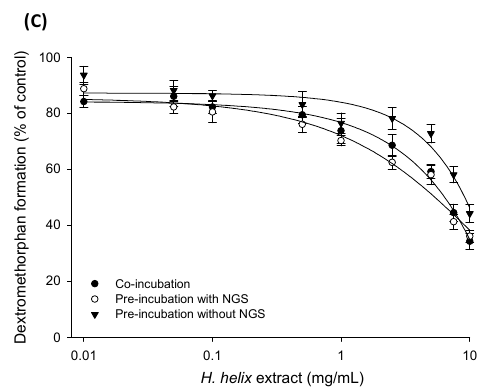
Figure 3. CYP-speci fi c metabolite formation as the percent of control after co-incubation and pre-incubation of H. helix extracts with and without NADPH in c-DNA expressed CYP isozymes; ( A ) CYP2C8; ( B ) CYP2C19, and ( C ) CYP2D6. Data was presented as the mean ± S.D. of the data obtained from two independent experiments.